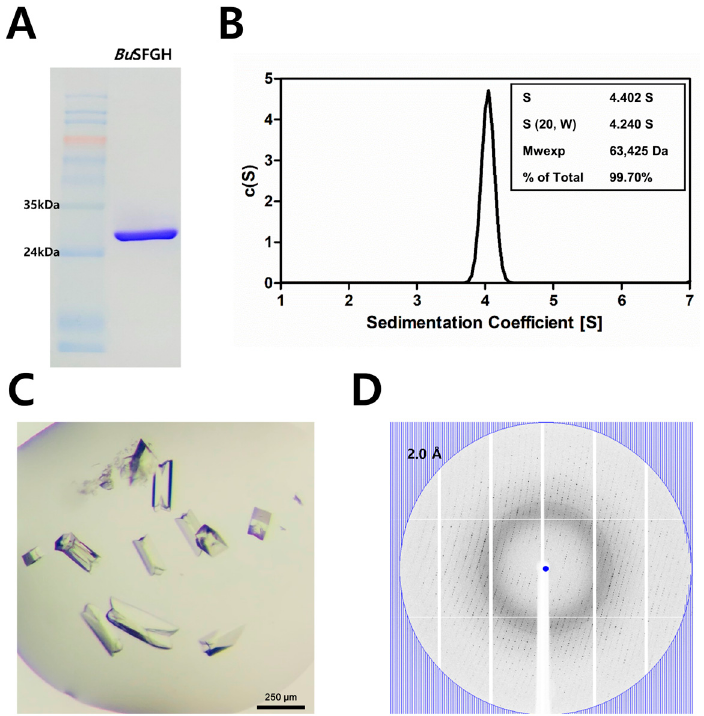
Figure 1. Recombinant Burkholderiaceae sp. S-formylglutathione hydrolase ( Bu SFGH) protein purifica- tion, crystallization, and X-ray diffraction data collection. ( A ) Sodium dodecyl-sulfate polyacrylamide gel electrophoresis (SDS-PAGE) analysis using finally purified Bu SFGH protein. ( B ) The analyti- cal ultracentrifugation (AUC) result shows purified Bu SFGH protein exists as dimer in solution. ( C ) Bu SFGH crystals were obtained under optimized conditions of 0.2 M ammonium citrate, dibasic